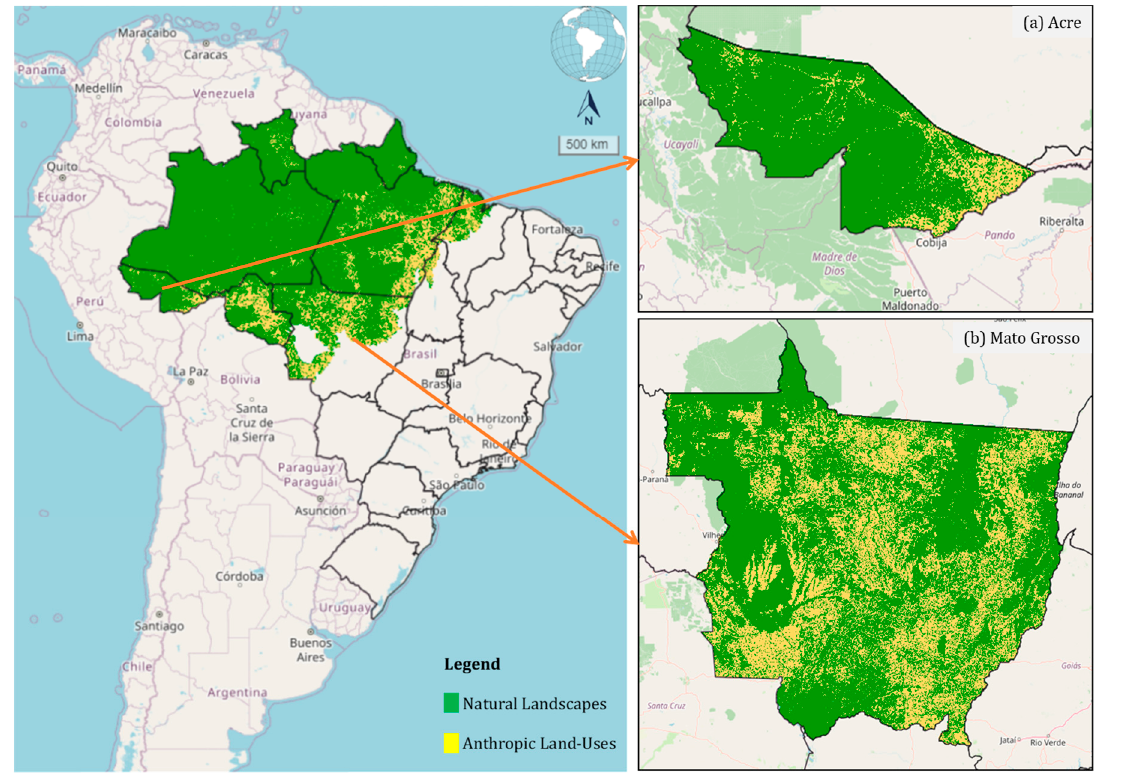
Figure 1. Land uses in Brazil’s Amazonian states and highlights to Acre and Mato Grosso in 2021 Souce: Mapbiomas [27].